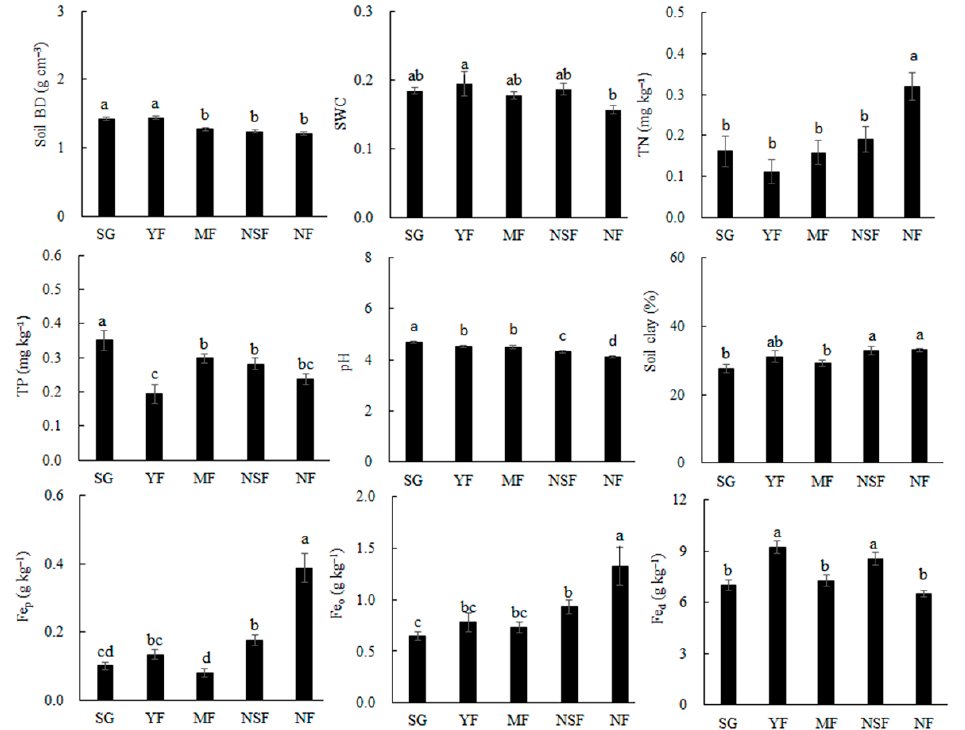
Figure 2. Basic physicochemical properties of the soils (0–90 cm) under different vegetation restoration types. Different letters indicate significant differences between vegetation types at the same soil depths at the 0.05 level. NF, natural forest; SG, shrub-grass land; PF, coniferous Pinus forest; MF: coniferous and broad-leaved mixed forest; and NSF, natural secondary forest. BD, bulk density; SWC, soil water content; TN, soil total nitrogen; TP, soil total phosphorus; Fe d , free Fe; Fe o , poorly crystalline; Fe p , organically complexed Fe.